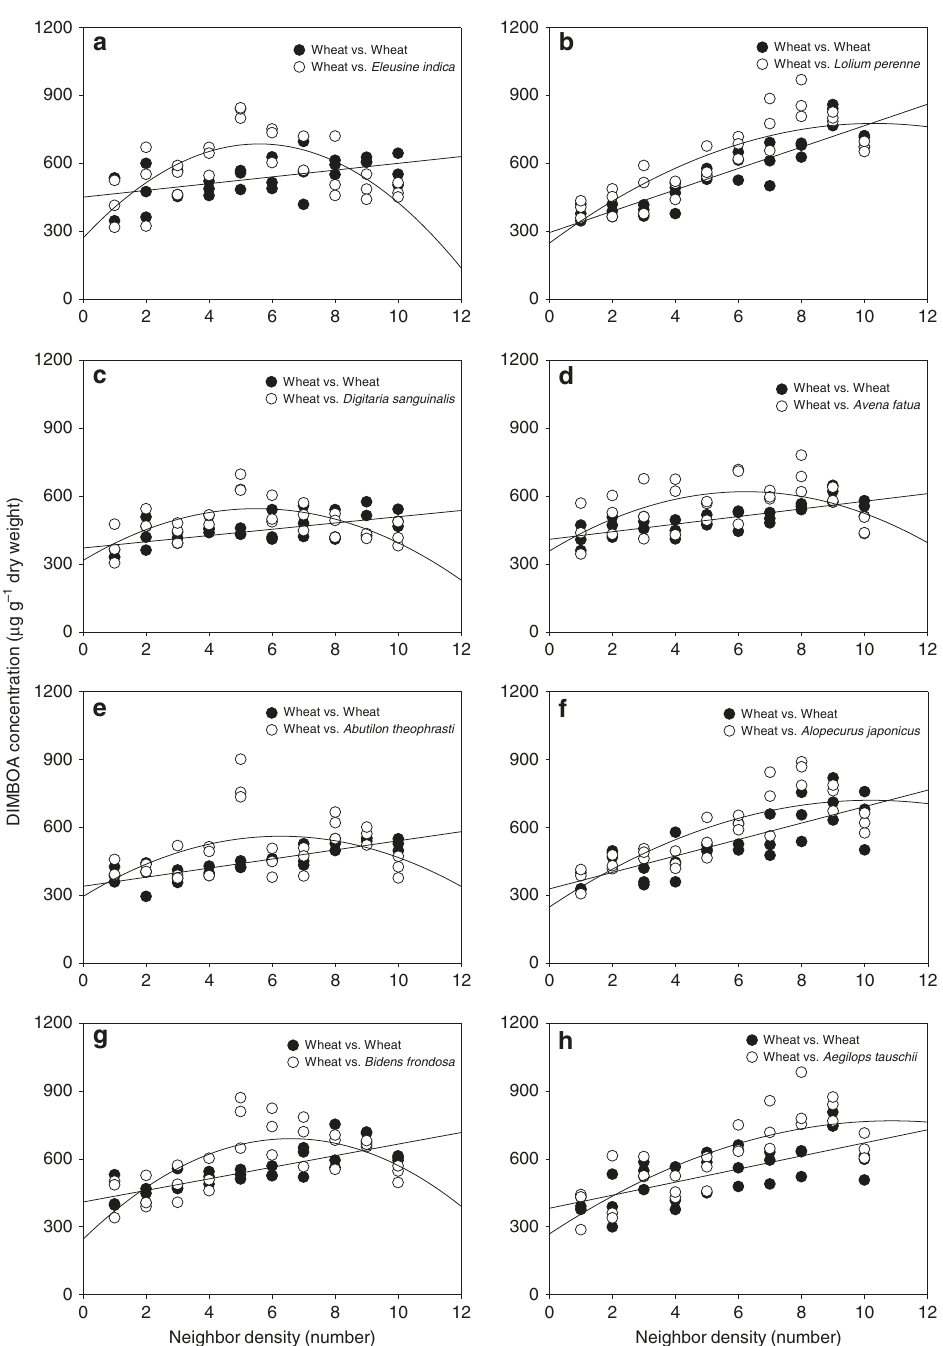
Neighbor density (number) Fig. 1 Variation in allelochemical DIMBOA concentration of wheat plants in response to eight commonly interacting weeds at different densities. a Eleusine indica ; b Lolium perenne ; c Digitaria sanguinalis ; d Avena fatua ; e Abutilon theophrasti ; f Alopecurus japonicus ; g Bidens frondosa ; h Aegilops tauschii . Regression lines were fi tted as the model results of the second-order polynomial of neighbour density and its interaction with species identity (wheat-weed), or a linear model (wheat-wheat). Signi fi cance of polynomial terms, e.g., neighbor density ( D ), density-squared ( D 2 ), species ( S ), D × S , and D 2 × S are shown